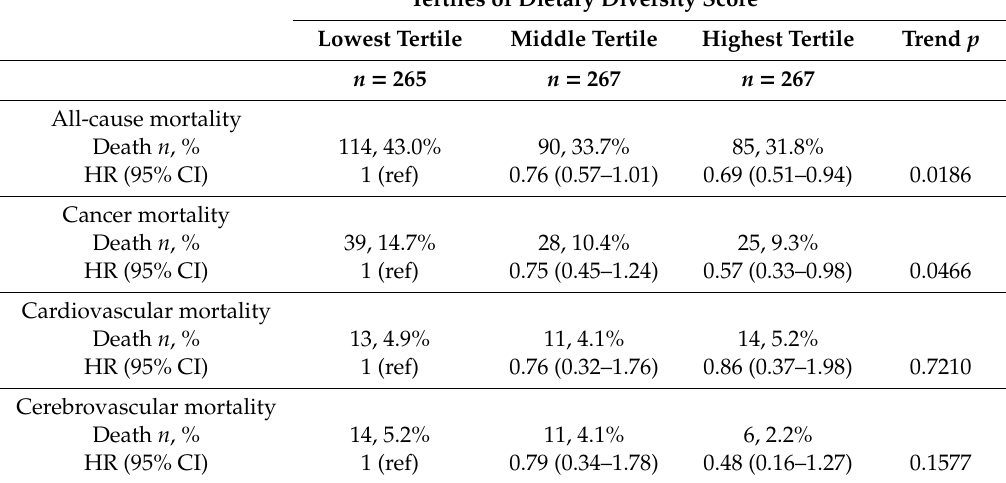
Table 4. Multivariate-adjusted hazard ratios 1 for all-cause and cause-specific mortality, according to the tertiles of dietary diversity